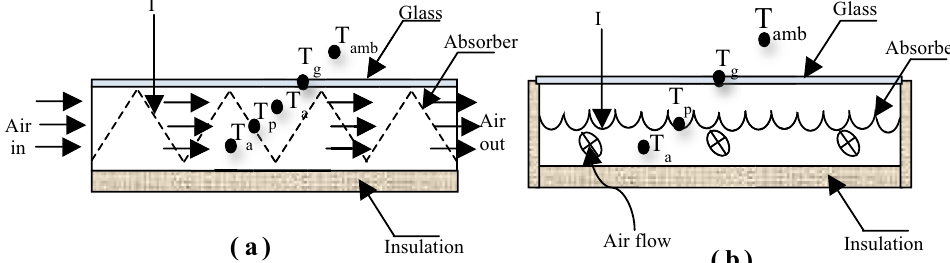
Fig. 2. Schematic diagram of through and single-glass solar air collectors: (a) with “ V ” -porous absorber plate and (b) “ U ” -corrugated absorber